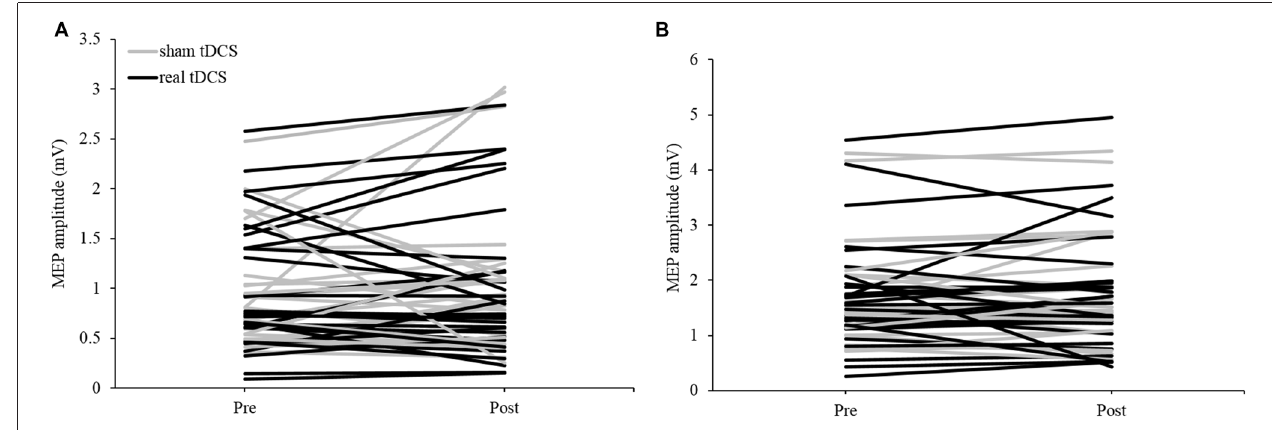
FIGURE 2 | Individual motor-evoked potential (MEP) responses following tDCS in (A) resting and (B) active extensor carpi radialis (ECR) conditions in both sham and real sessions.